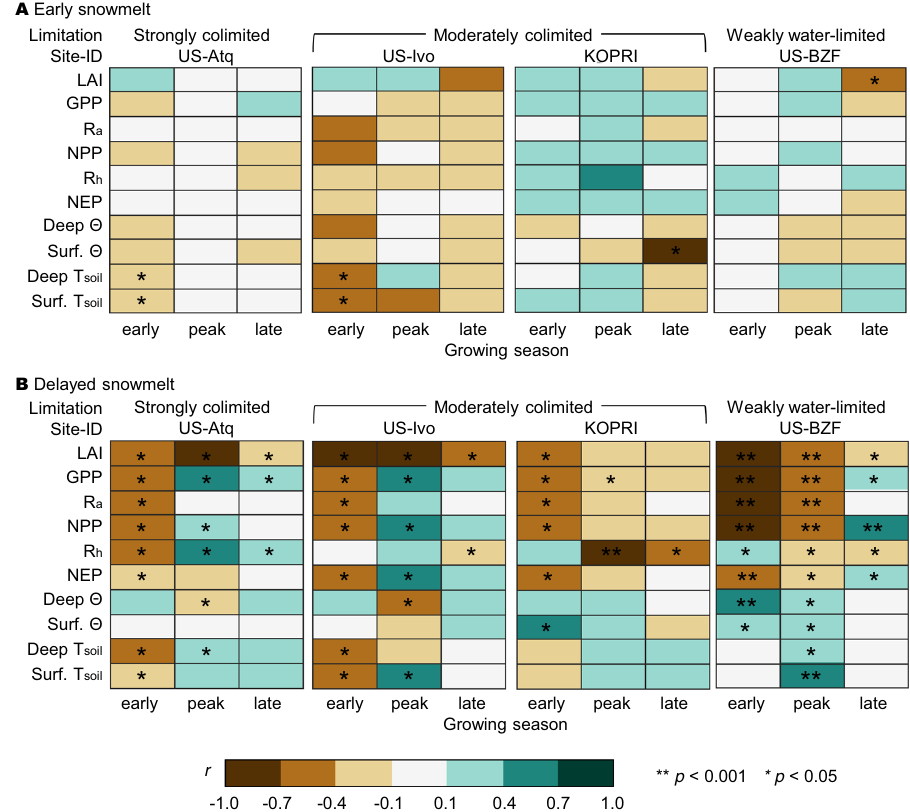
Fig. 4 Seasonal effects of early or delayed snowmelt timing on ecosystem processes. A least-squares linear regression was applied for the years when meteorological conditions were similar (see Methods — Correlation analysis). A Pearson correlation ( r ) between early snowmelt days (deviation in snowmelt timing each year from the mean snowmelt timing) and the changes in each ecosystem process (leaf area index, LAI; gross primary productivity, GPP; autotrophic respiration, R a ; net primary productivity, NPP; heterotrophic respiration, R h ; net ecosystem productivity, NEP; deep and surface soil moisture, Θ ; deep and surface soil temperature, T soil ) from the ED2 simulation for each year (i.e., the difference between the seasonal mean and the mean value over the years), and B Pearson correlation ( r ) between the delayed snowmelt days and the difference between the ED2 modeled results with GSI and SGSI. Other sites are presented in Fig.